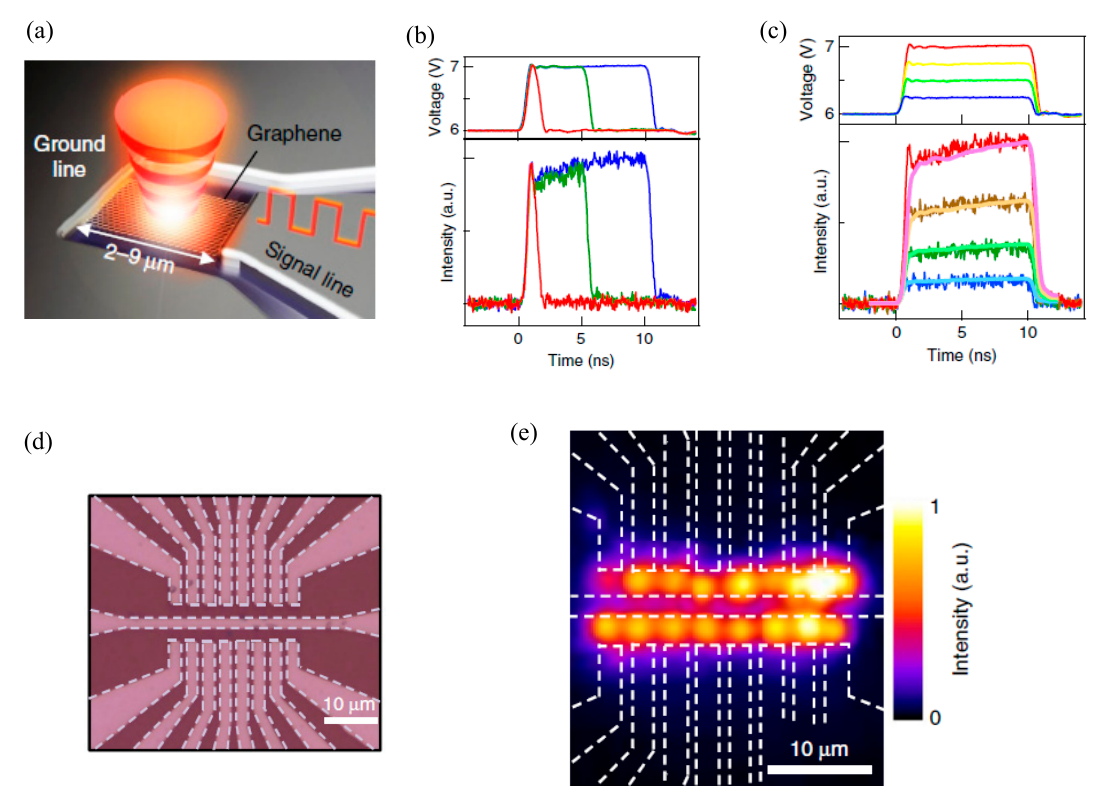
Figure 6. ( a ) The structure of the graphene emitter black body emitter encapsulated with Al 2 O 3 , the CVD graphene was deposited on the square SiO 2 / Si substrate, which is attached with source and drain electrodes, where high modulation optical signal obtained by applying input signals. ( b ) Shows time resolve emission from the device under different pulse width (1, 5 and 10 ns) and voltage amplitude (6–7 V), ( c ) the time resolve emission from the device with a pulse width of 10 ns and amplitude 6 to 7 V. ( d ) The optical image of the highly integrated graphene 2 × 8 arrays thermal emitter with CVD graphene, with size 2 × 2 µ m and pitch 3 µ m. ( e ) NIR camera image of the light emission from the arrayed device, each array is connected to the same voltage (10 V), and series resistance is introduced with each array to demonstrate the relative uniform light emission from each device [22]. Table 1. Summary of the graphene-based thermal emitters.